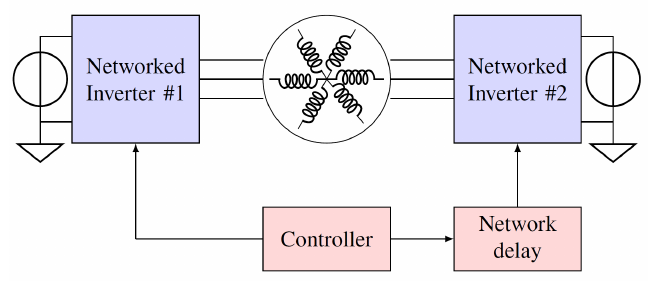
Figure 6. Delay impact evaluation simulation